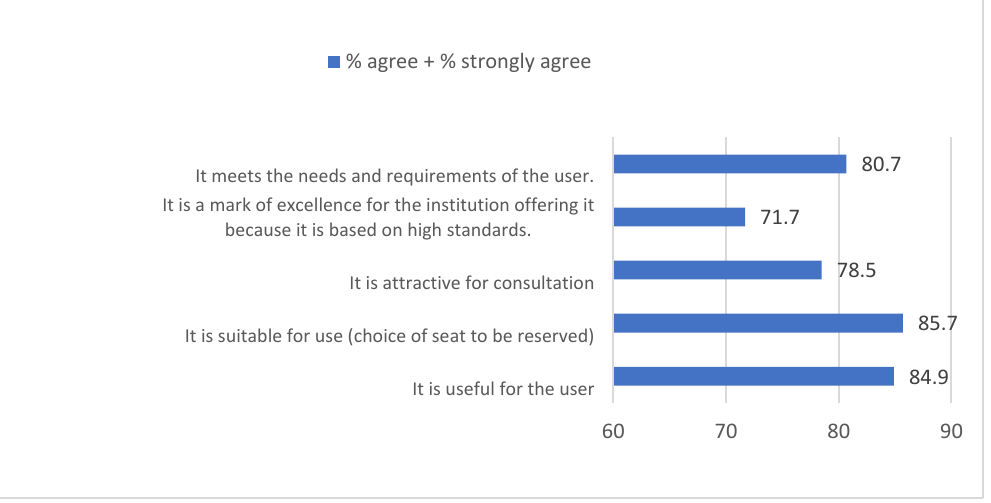
Figure 13. Percentage of use of an online seat reservation system according to branch of study.